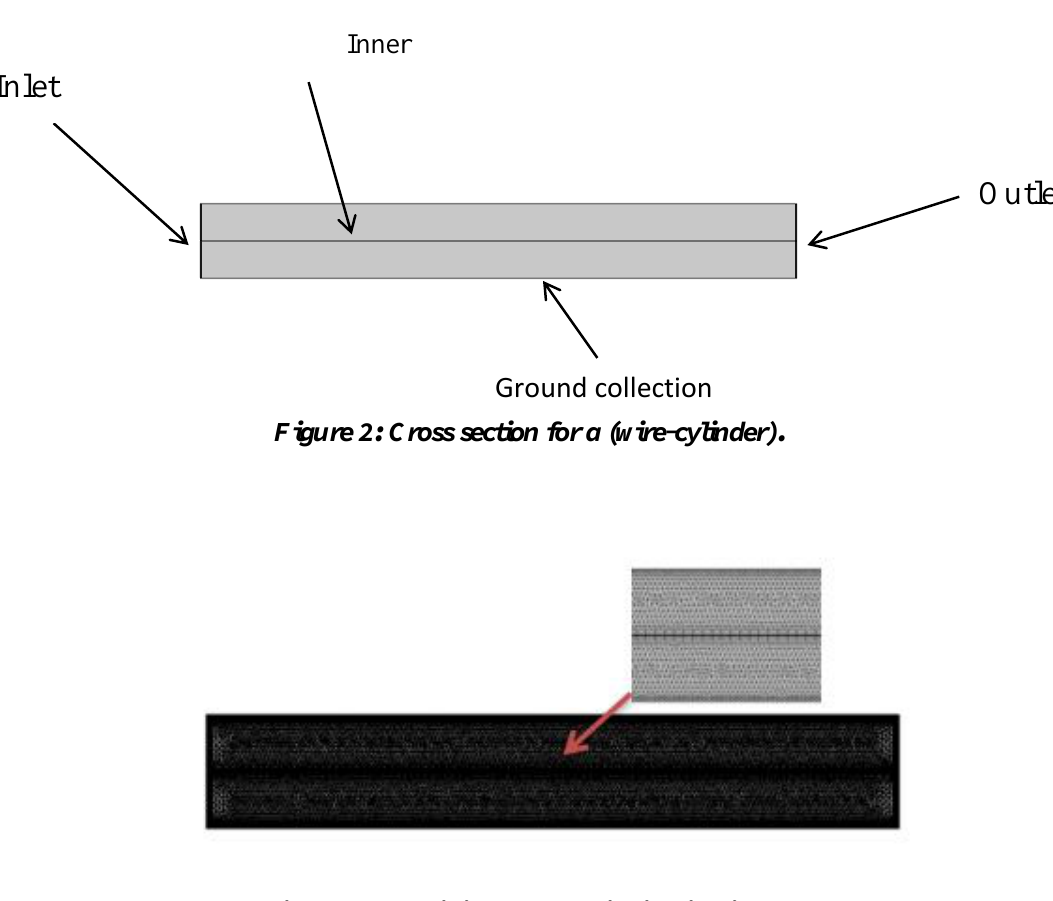
Figure 3: The finite element distribution in